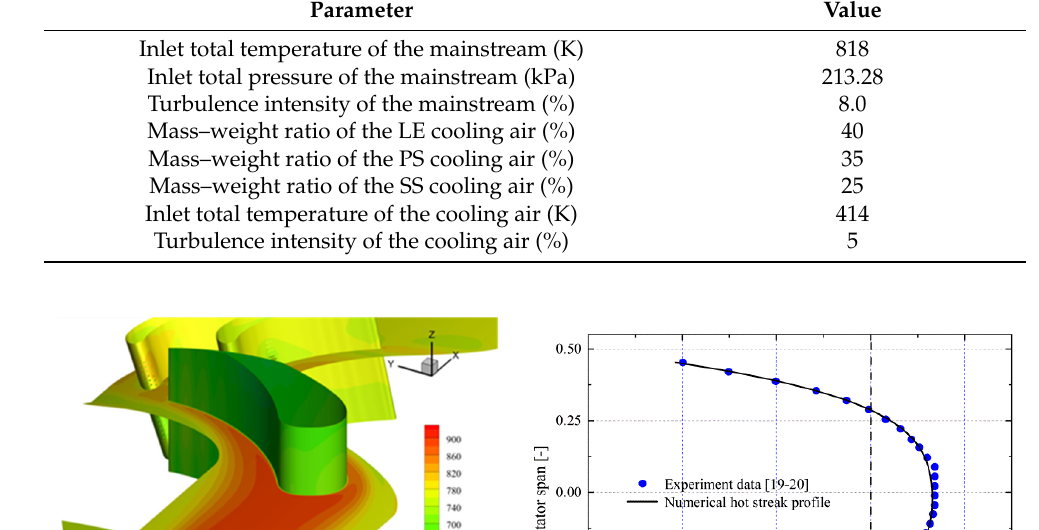
Figure 5. Normalized pressure and temperature ratio convergence history of the unsteady simula- tion. ( a ) Pressure ratio convergence history; ( b ) temperature ratio convergence history. 2.2. Thermal Parameter Definition To analyze the cooling performance of the rotor blade, Equations (1–3) are used to explain the definitions of thermal parameters; see in Figure 6 [9].